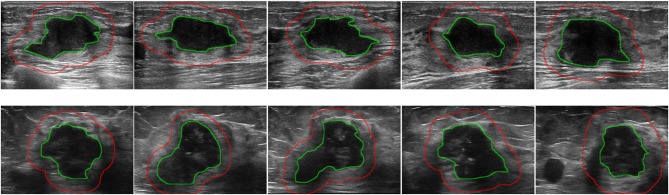
Examples of ultrasound slices overlapped with intratumoral regions (green) and peritumoral regions (red) from two patients. (Top) A patient with positive ALN. (Bottom) A patient with negative ALN.